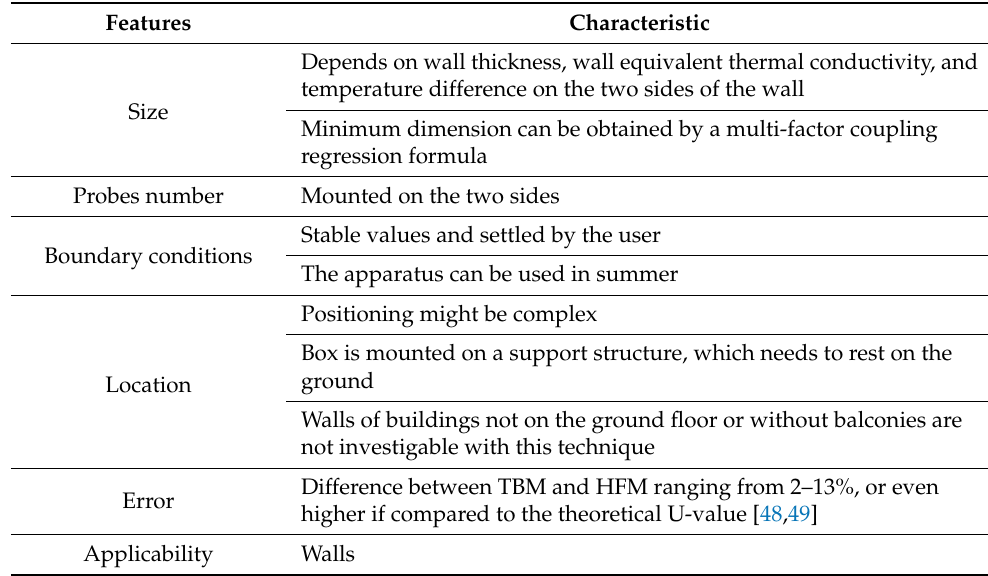
Table 8. Characteristics of the simple hot box method (source: authors’